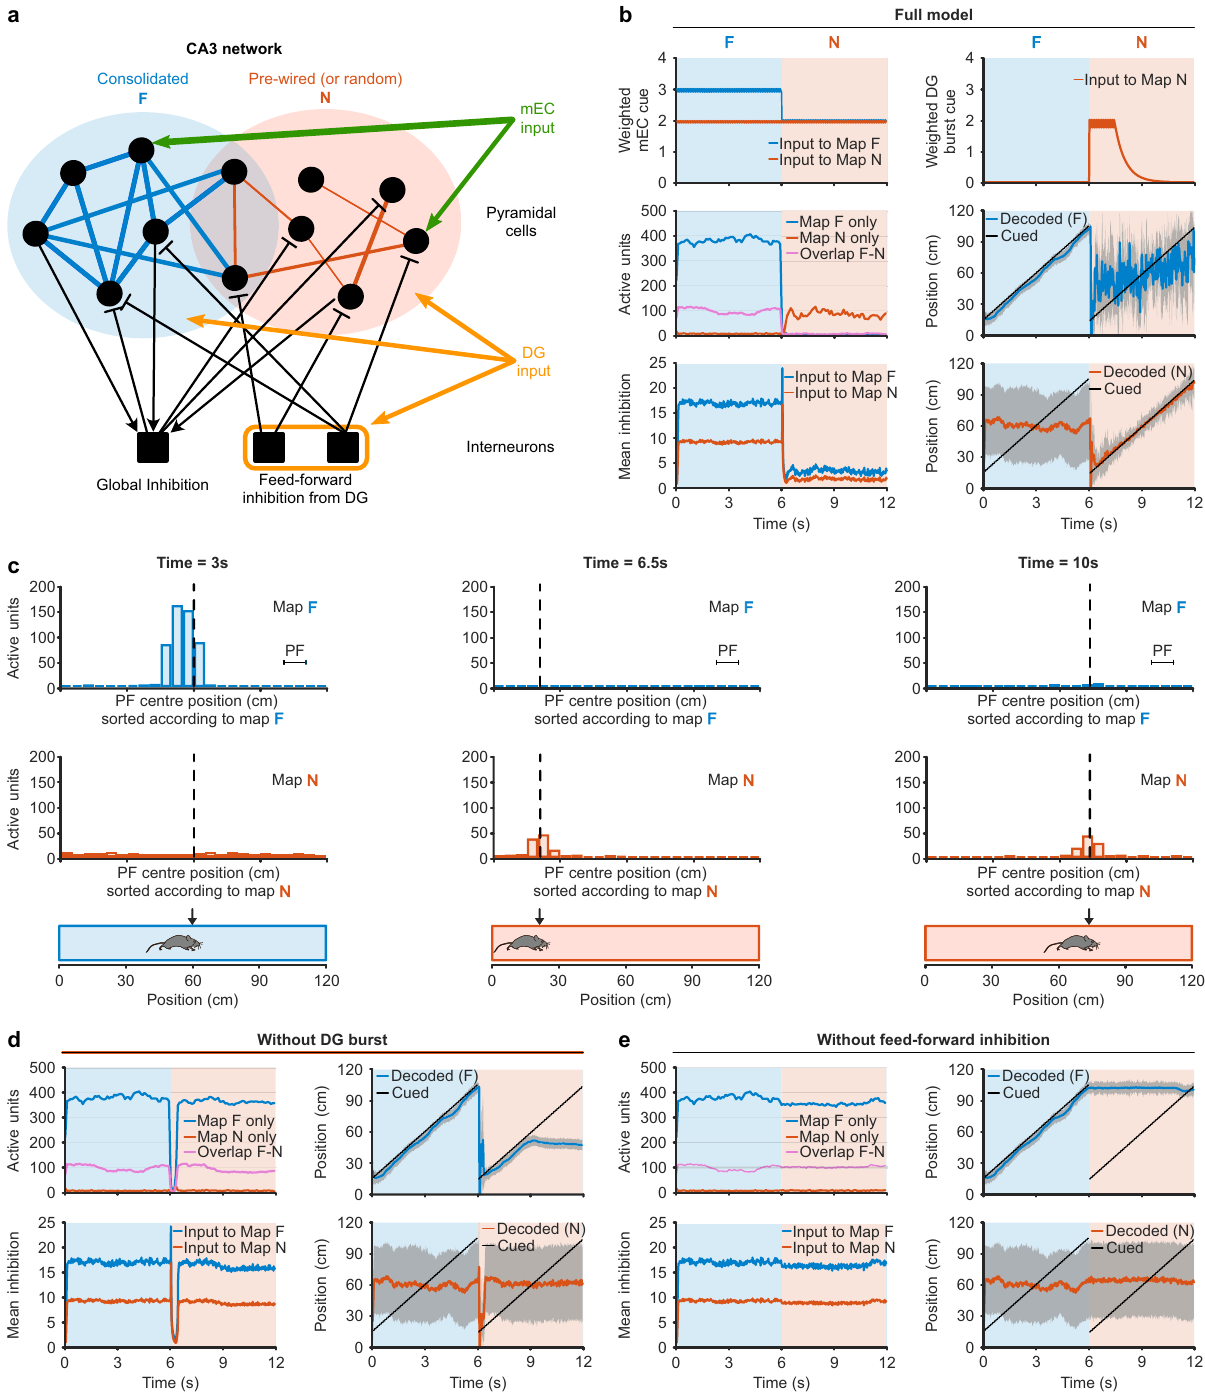
PF centre position (cm) sorted according to map N